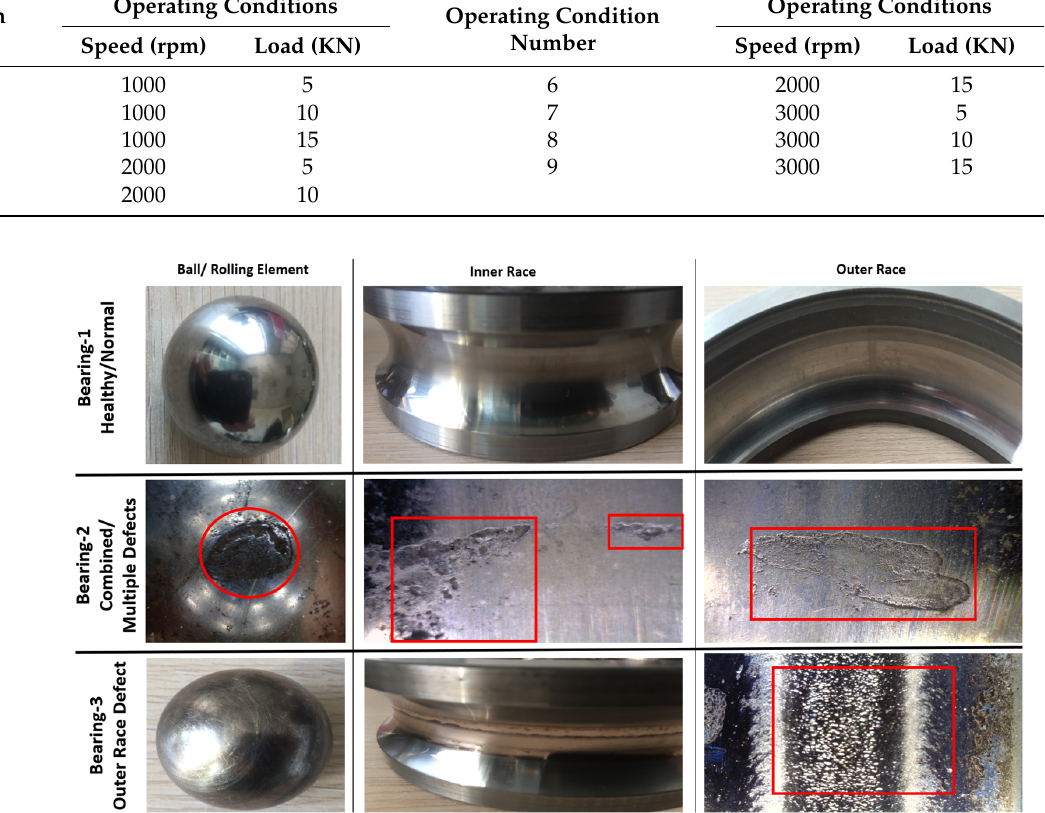
Figure 7. Healthy and defected bearings considered in case study-1.